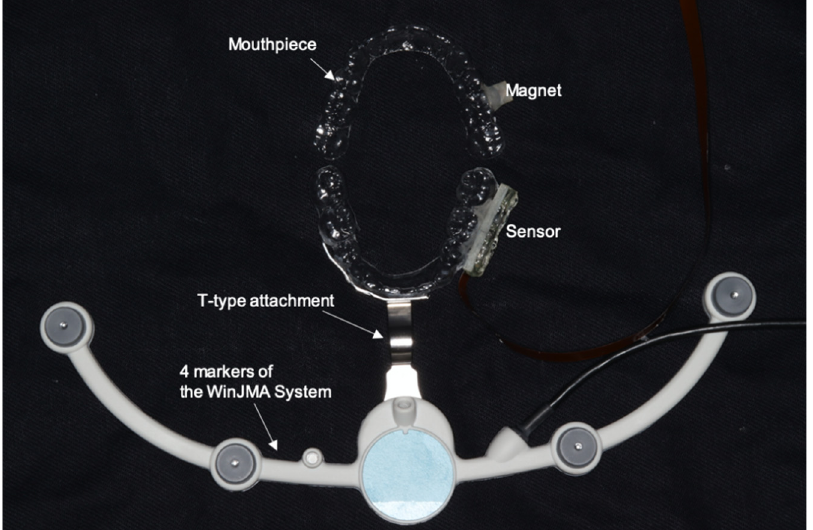
Figure 10. Setup of simultaneous measurement with the present sensor and the WinJMA system.